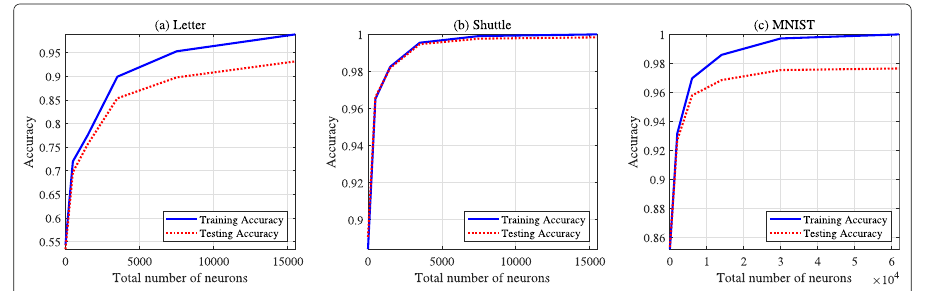
Fig. 3 Training and testing accuracy against size of HNF using DCT in every layer. Size of an L -layer HNF is represented by the number of DCT-based nodes, counted as The number of nodes in the first layer (2 n ( 1 ) ) is set according to Table 2 for each dataset